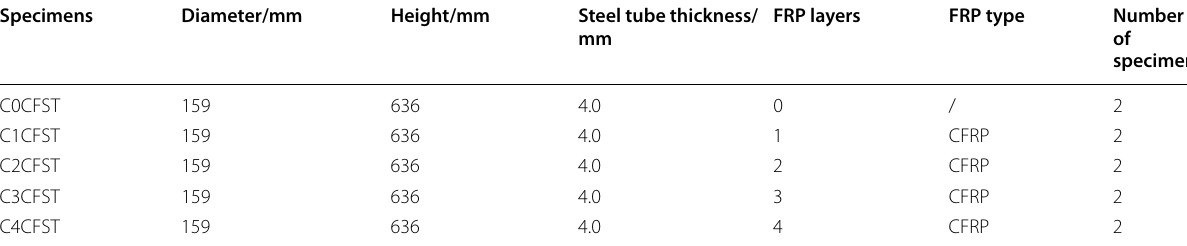
Table 1 FRP-strengthened CFST columns Specimens